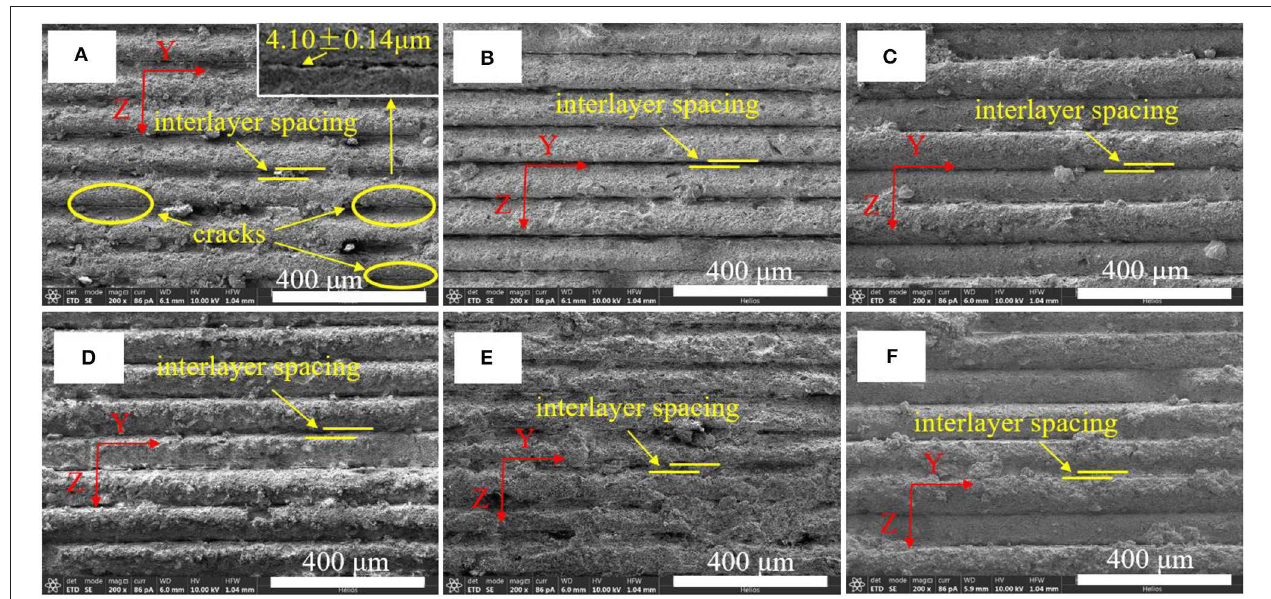
FIGURE 2 | The layered structure of sintered samples observed by SEM: (A) 30min; (B) 60min; (C) 90min; (D) 120min; (E) 150min; (F) 180min.